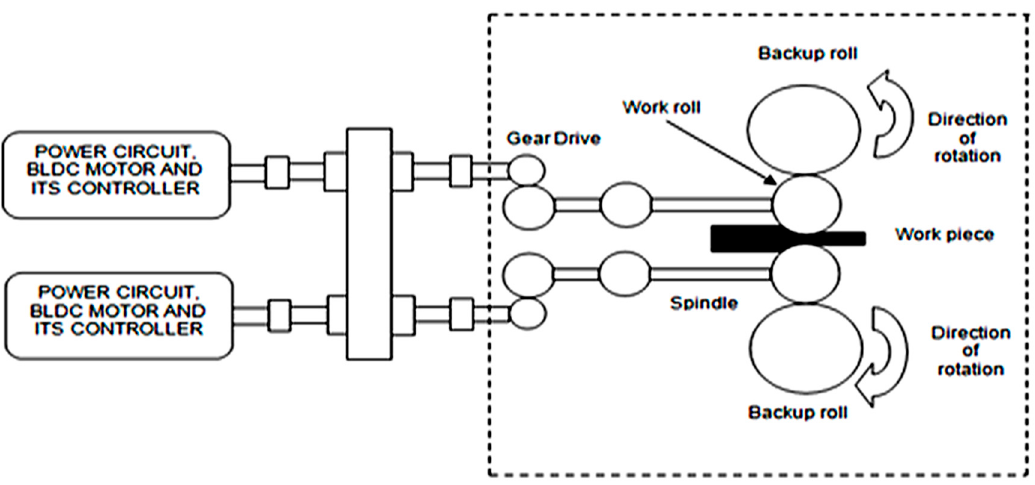
Figure 1. Schematic of two identical brushless electric DC (BLDC) motor drive systems coupled to steel rolling mill through reduction gears.